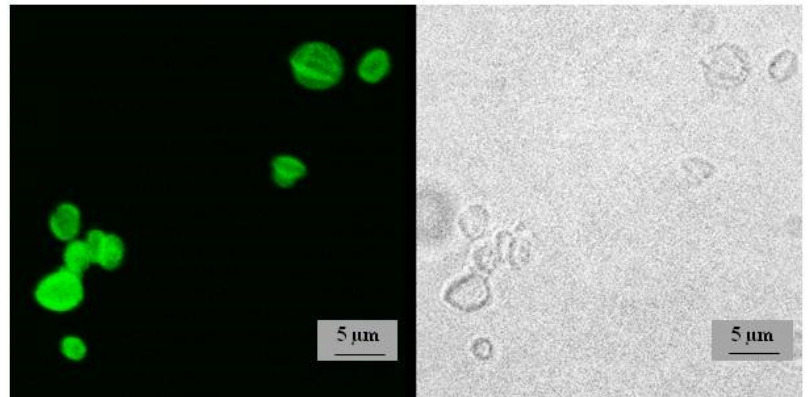
Figure A4. Reversal of the zeta-potential during the capsules formation.